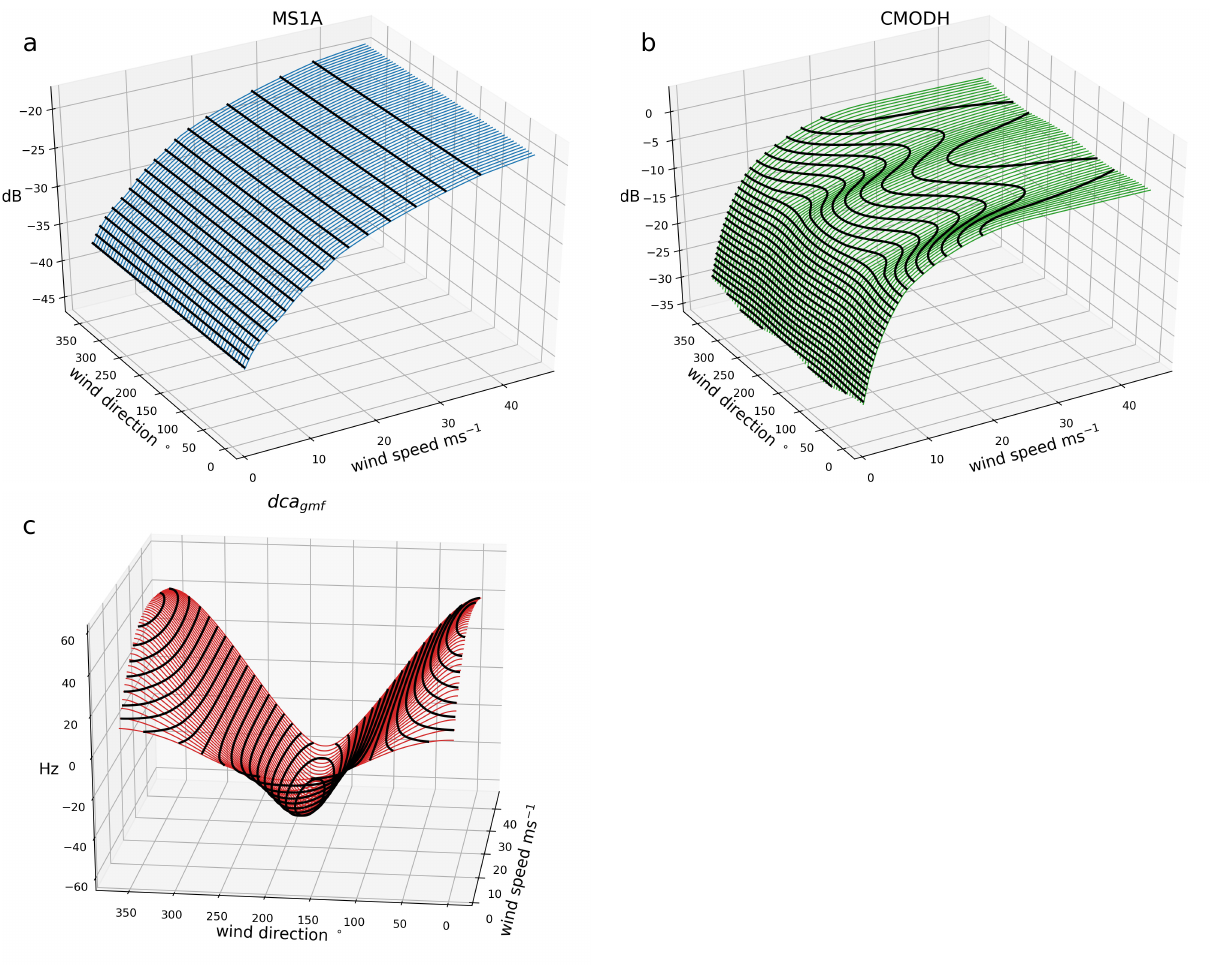
Figure 1. Geophysical model functions that relate wind speed (ms − 1 ) and direction ( ◦ relative to radar) to a measured quantity. The GMFs are shown for a 30 ◦ incidence angle and the black lines indicate isolines of constant backscatter intensity (dB) and Doppler shift (Hz). The 0 ◦ wind direction is wind blowing towards the radar and angles increase clockwise. ( a ) Shows the crosspol GMF, MS1A [7]; ( b ) the copol GMF, CMODH [14]; and ( c ) a GMF for the Doppler centroid anomaly, dca gmf